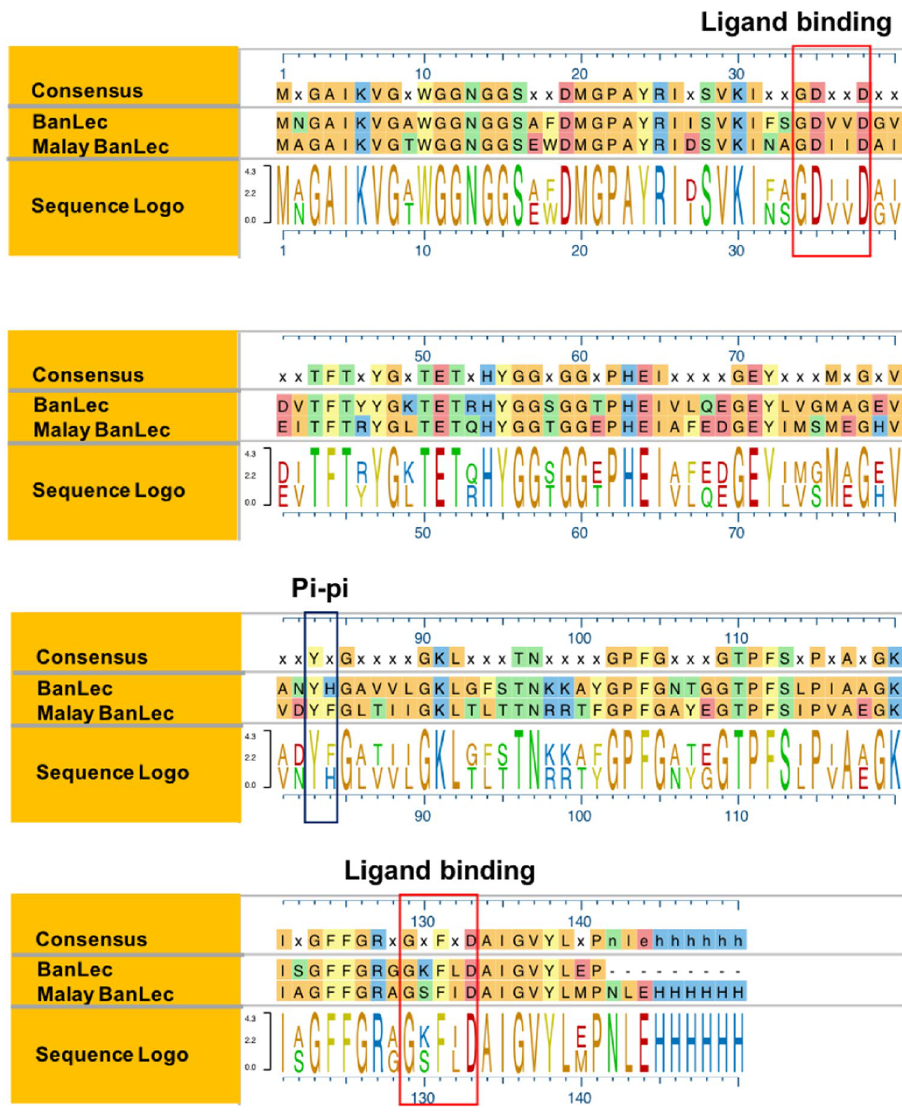
Figure 1. Malay BanLec is structurally similar to BanLec. Amino acid sequence alignment of BanLec and Malay BanLec (middle rows) from amino acids 1 (top left) to 141 (bottom right). The 6 × His-tag (LEHHHHHH) is indicated at the end of the Malay BanLec sequence. The amino acids predicted to undergo pi– pi stacking (“pi–pi”) and the predicted ligand binding loops of the carbohydrate binding sites (“ligand binding”) in Malay BanLec are outlined in black and red, respectively, aligned with those known sites in BanLec. Sites of amino acid identity (“consensus”) are indicated in the top row in the colored boxes; “x” indicates that identity is not shared at a particular site. The bottom row (“sequence logo”) depicts the sequence of both lectins, with amino acids from both sequences represented if there is not identity at a particular site. Malay BanLec is 63% identical to BanLec at the amino acid level. The figure was generated using Microsoft PowerPoint 2016 (https :// www.micro soft.com/en-us/micro soft-365/power point ) and Adobe Illustrator, version 22.1.0 (https ://www.adobe .com/produ cts/illus trato